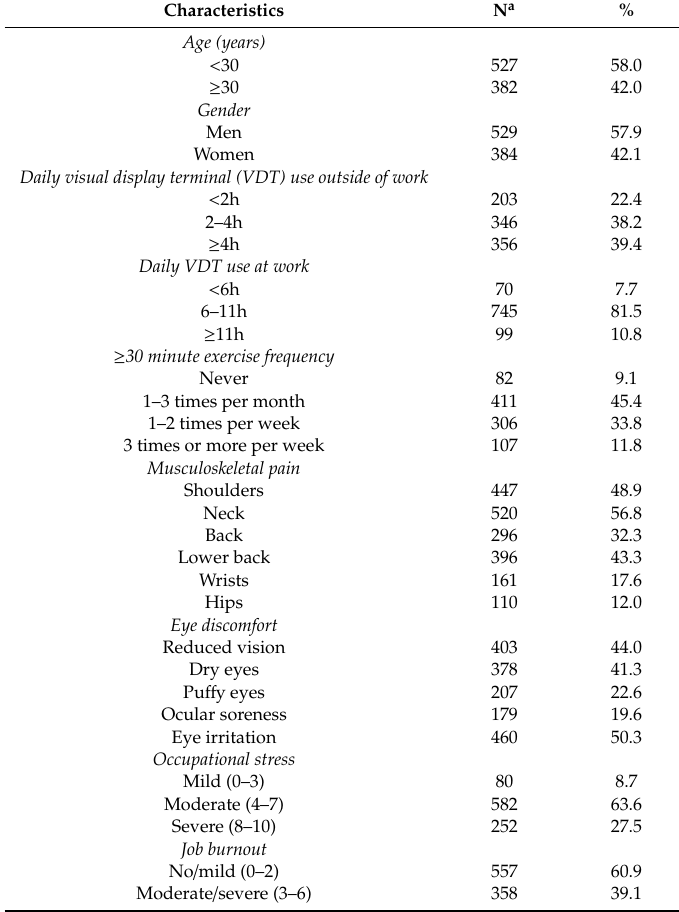
Table 1. Characteristics of the study